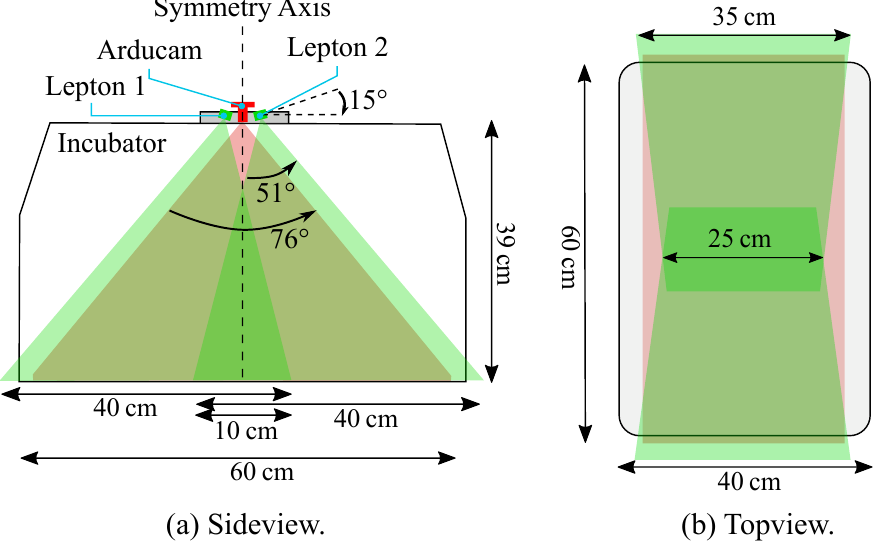
Figure 3. ( a ) Side view of the arranged camera setup and field of view. ( b ) Top view of the arranged camera setup and the covered mattress